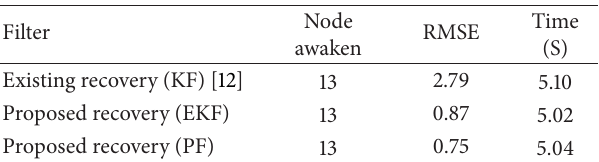
Table 7: Performance comparison: coverage hole in WSHUN—(A) 1st recovery.